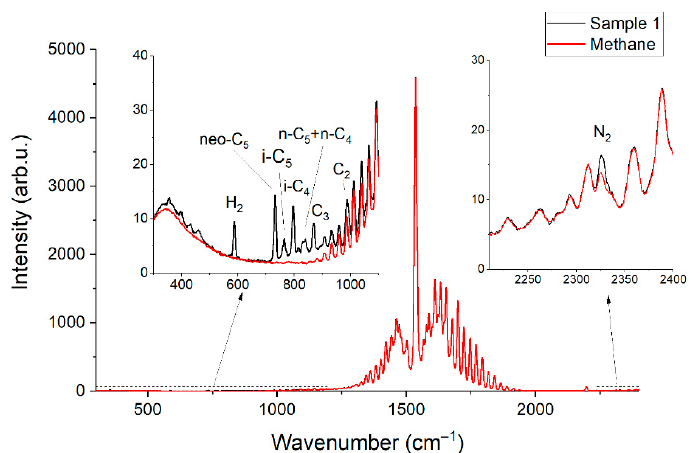
Figure 2. Raman spectra of pure methane and sample 1.